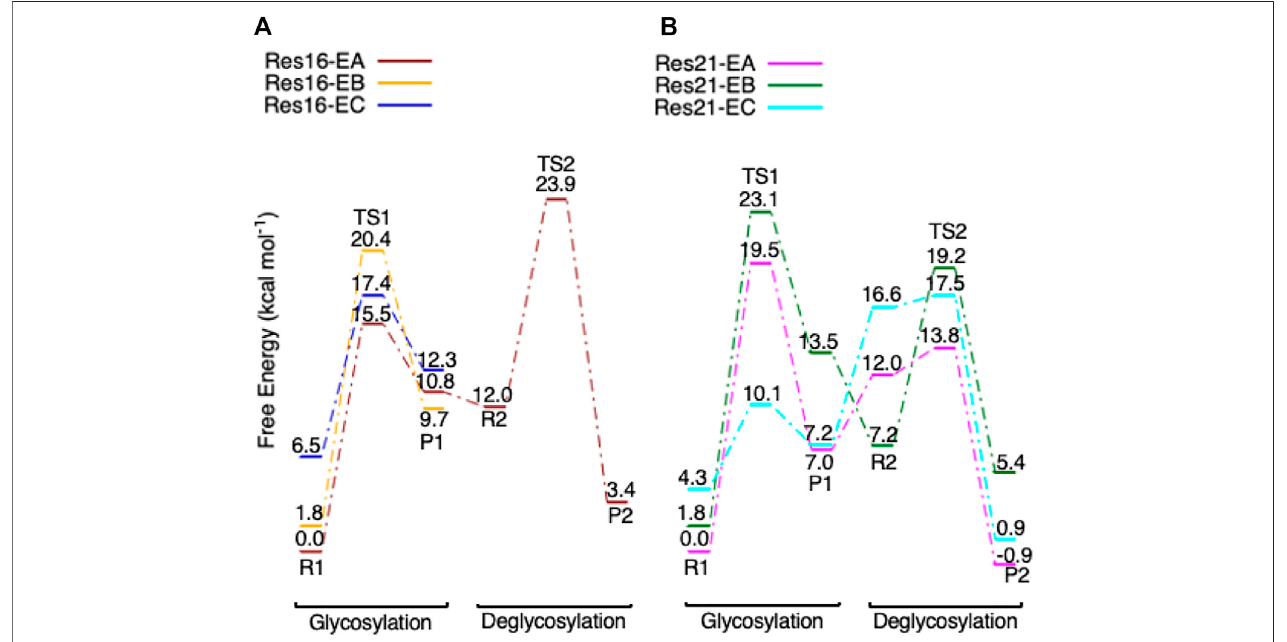
FIGURE10| Freeenergydiagramofglycosylationanddeglycosylationfordifferentconformersofmodels (A ,left) Res16-E and (B ,right) Res21-E basedon8CEL.